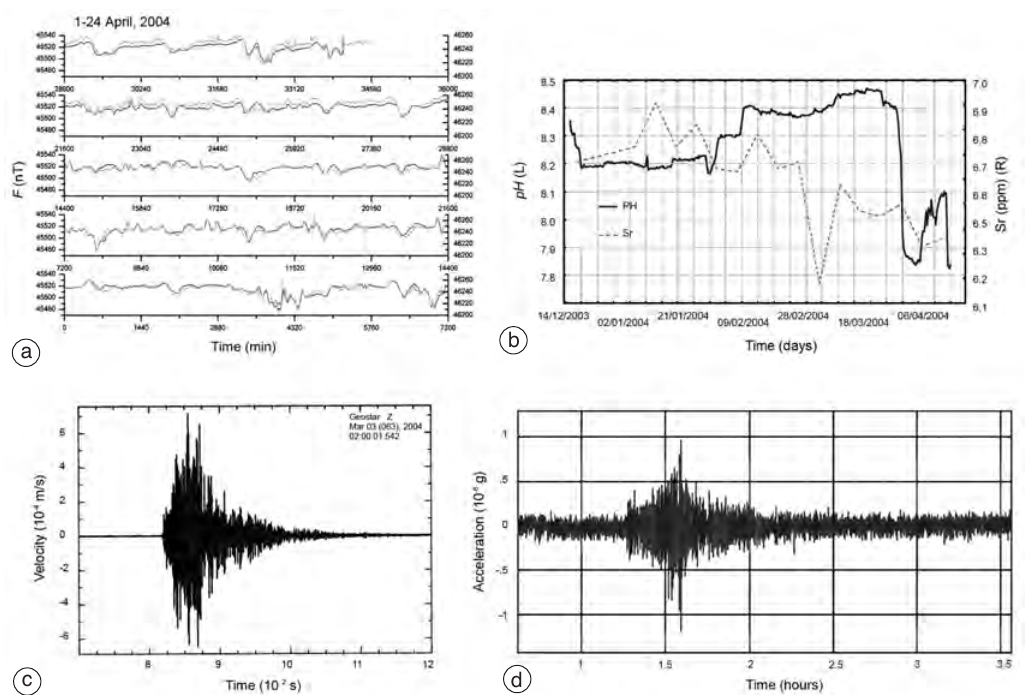
Fig. 13a-d. ORION network measurements acquired at the base of the Marsili seamount: a) one month of mag- netometer measurements (April 2004, red line) compared with the Italian land reference observatory (L’Aquila) in Central Italy; b) pH measurements by the electrode analyser compared with the chemical analysis (Stronzi- um) performed on the samples collected by the water sampler; c) local event of the Southern Tyrrhenian Sea (3 March 2004, M L = 4.6) recorded by the seismometer; d) teleseismic event recorded by the gravity meter (26 De- cember 2003, M S = 6.8,